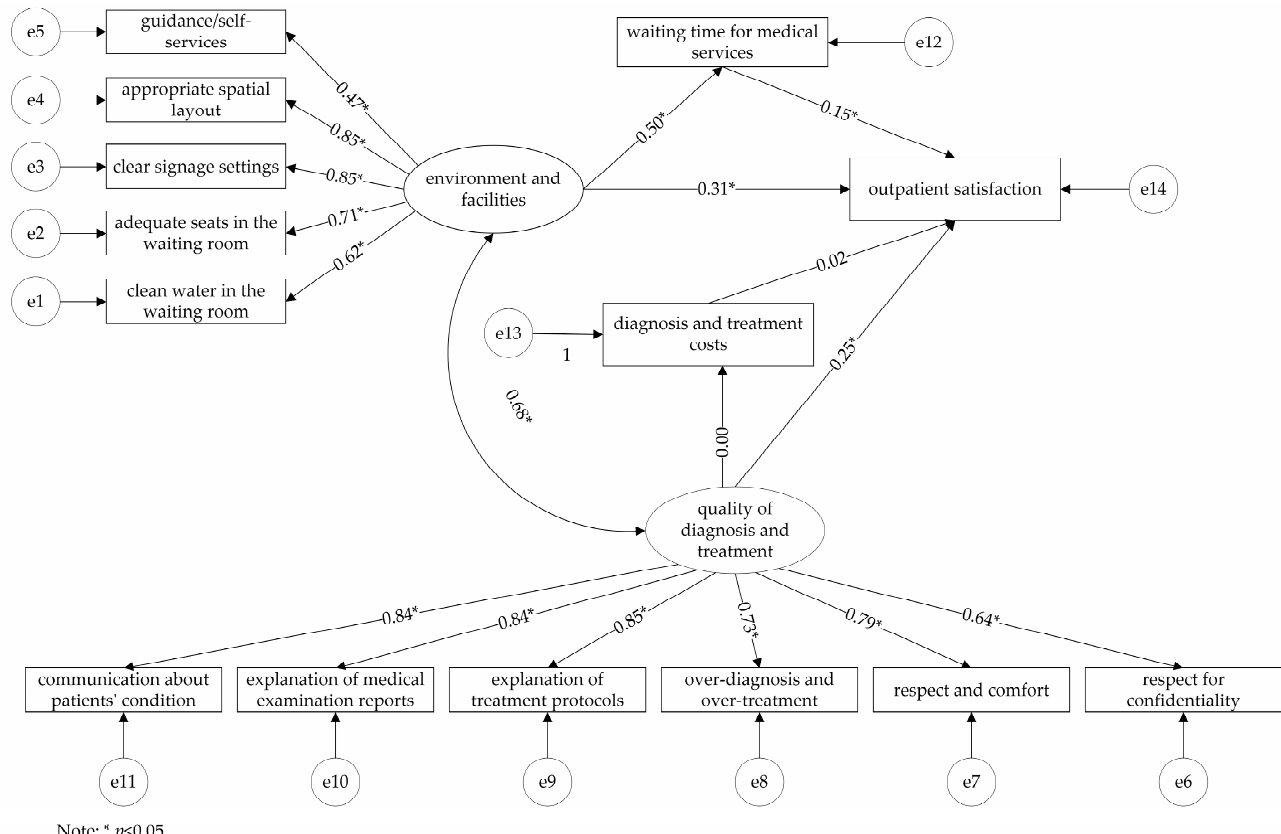
Figure 1. The initial model of outpatient satisfaction in provincial tertiary hospitals.